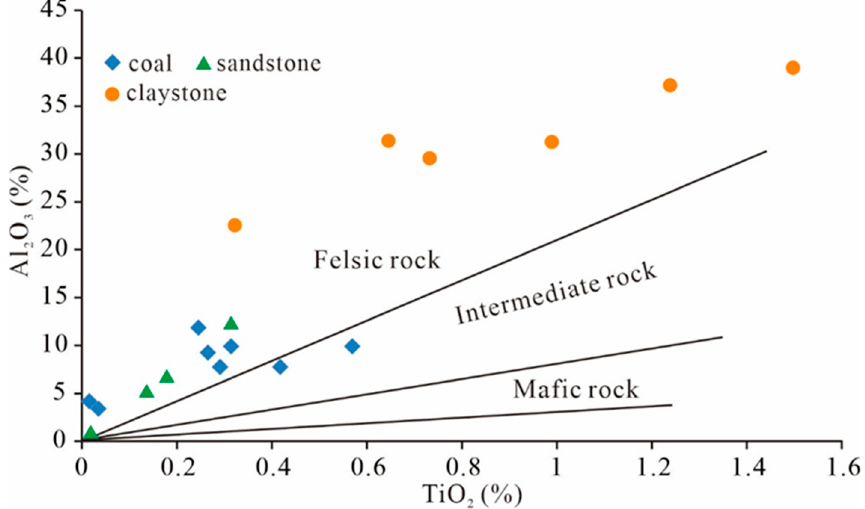
Figure 8. The plot of TiO 2 versus Al 2 O 3 contents for the coal and non-coal samples.